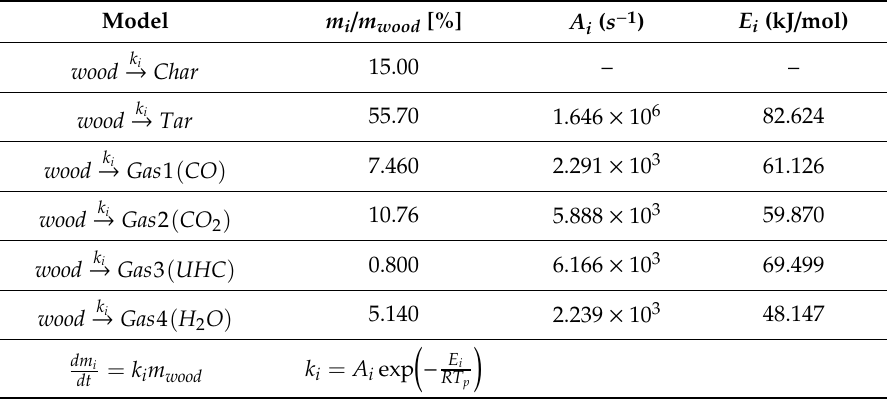
Table 2. Gasification and / or devolatilization model 2